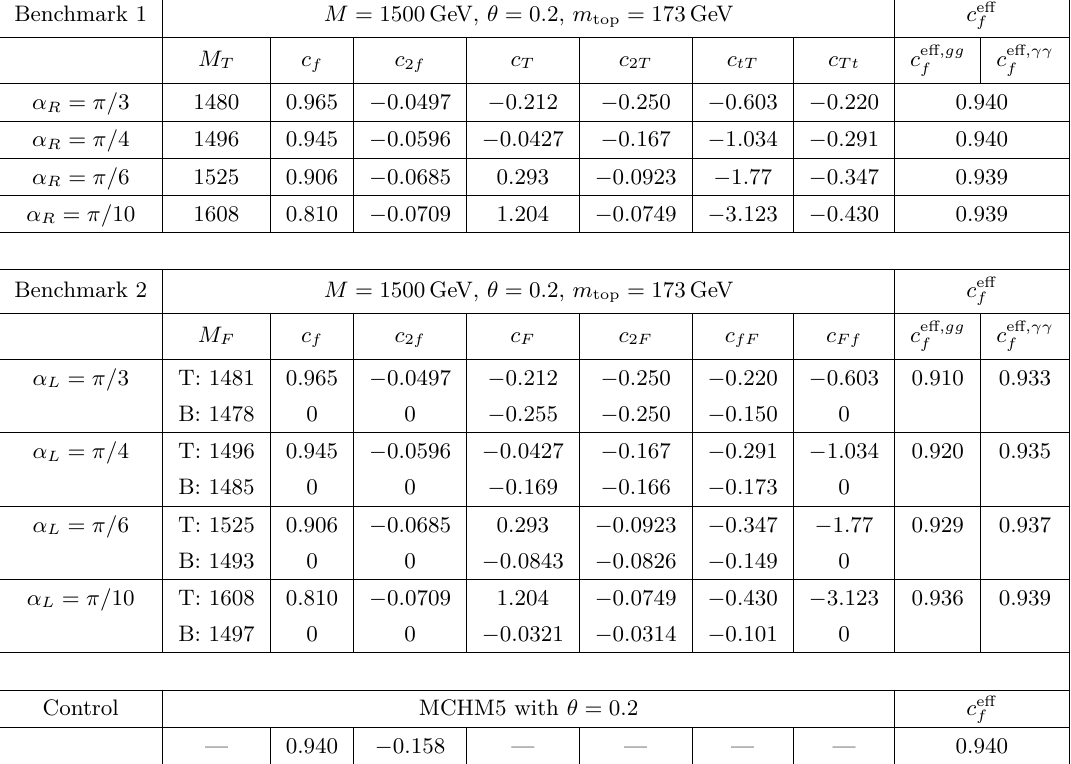
— — — — 0 . 940 Table 7 . Couplings of the Higgs h to top (bottom) quarks and top partners relevant for our calculation. Benchmark 1 corresponds to the singlet, while benchmark 2 to the doublet (here, F = T, B and f = t, b ). The “control” corresponds to the model MCHM5 without light top